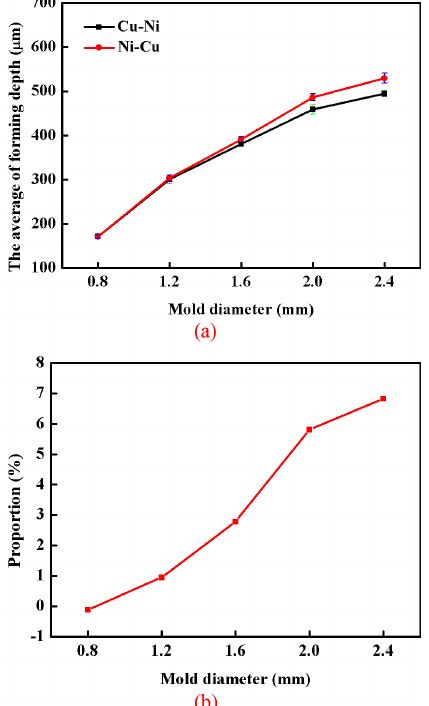
Figure 4. ( a ) The feature size effect on forming depth; ( b ) the feature size effect on difference degree of forming depth between two different layer stacking sequences.